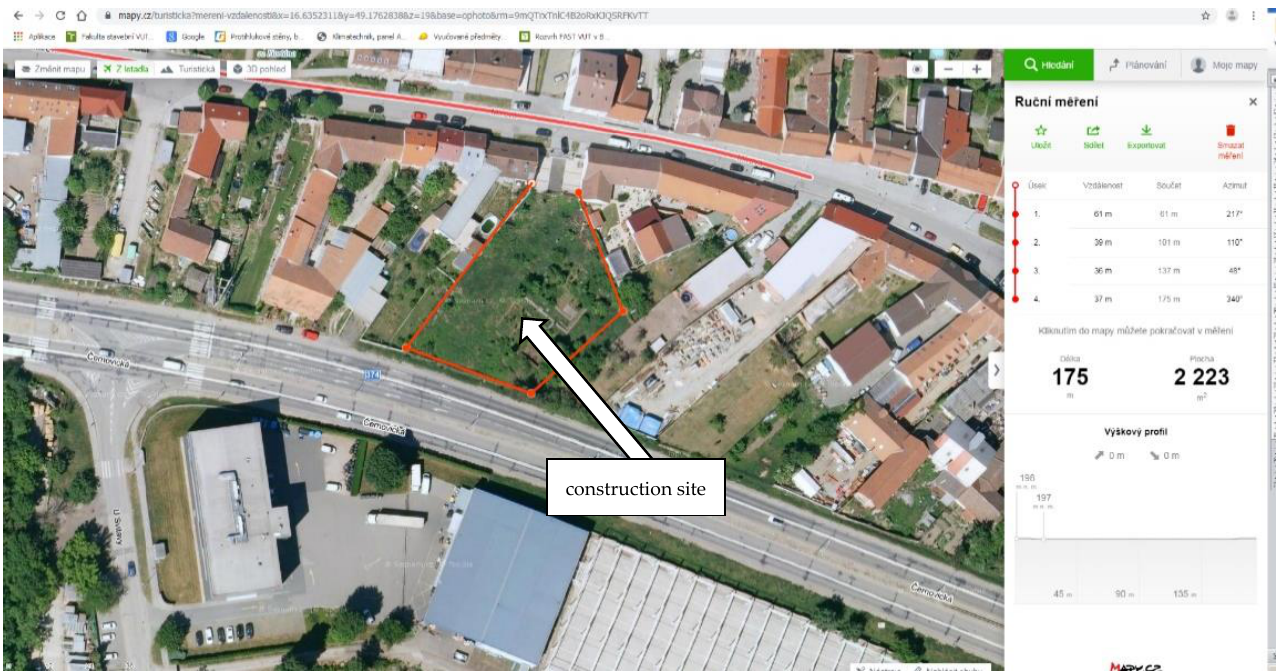
Figure 3. The area of the construction site and the area for the trajectories of construction machines during the construction of the investigated building project.